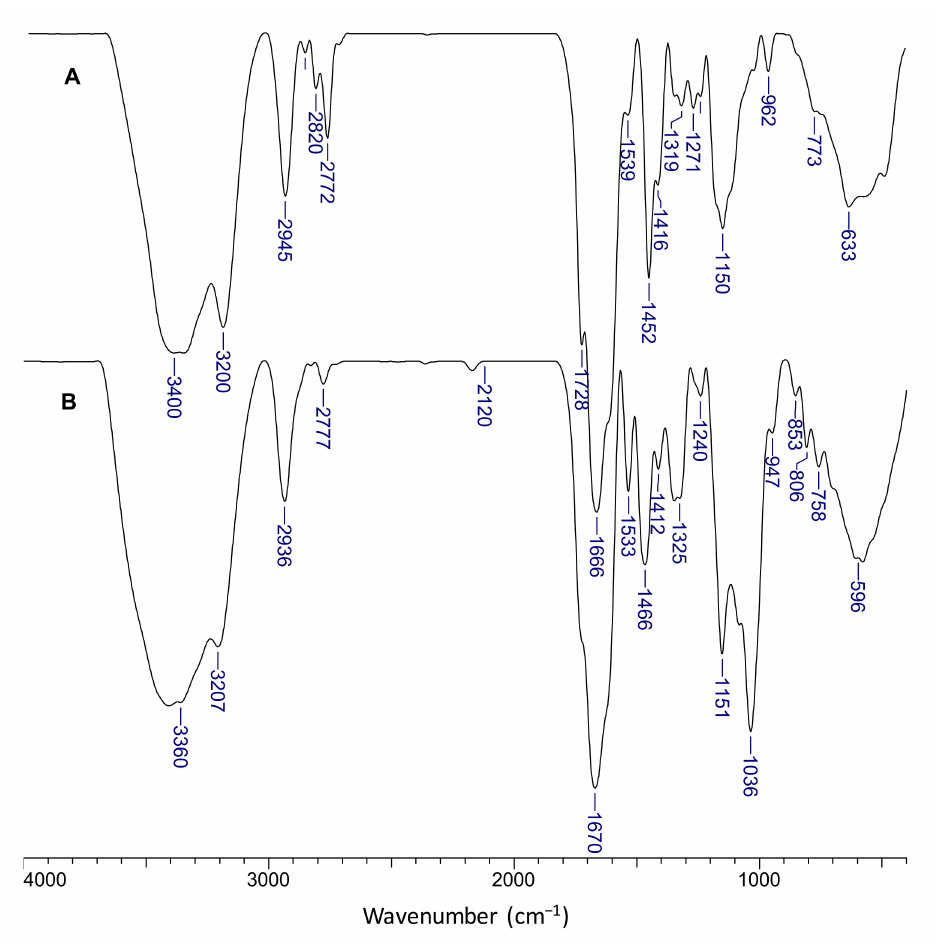
Figure 7. FTIR spectra of the s-IPN50 cryogel ( A ) and the corresponding IPN cryogel ( B ). Table 4. Composite cryogels selected for the investigation of CCM